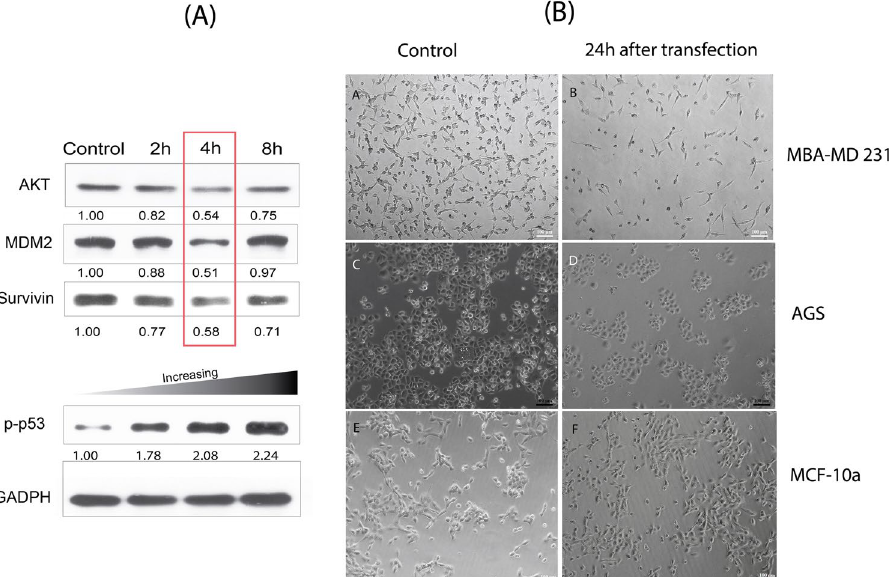
Figure 5. ( A ) Levels of suppression of Survivin and expression of p53 for 2 h, 4 h and 8 h for MBA-MD 231 cells. ( B ) Light microscopy images of the three cell types using nanoconstruct with the AS1411 aptamer.